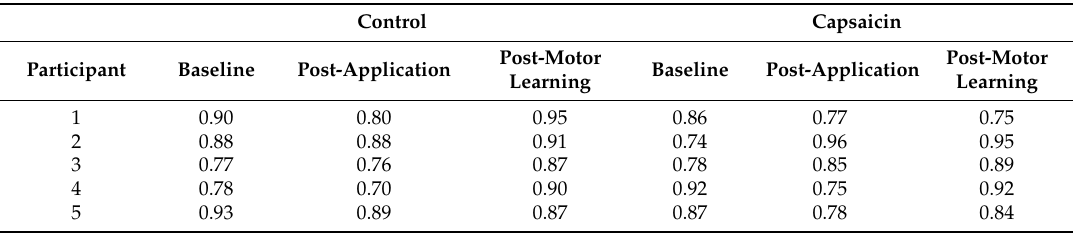
Figure 7. IO curves of control ( A ) and capsaicin ( B ) participants. Note increase in slope for the control ( A ) participants, representative of the significant change in the group data. Table 2. Goodness of fit data (R 2 ) for the capsaicin and control groups at baseline, post-application, and post-motor learning